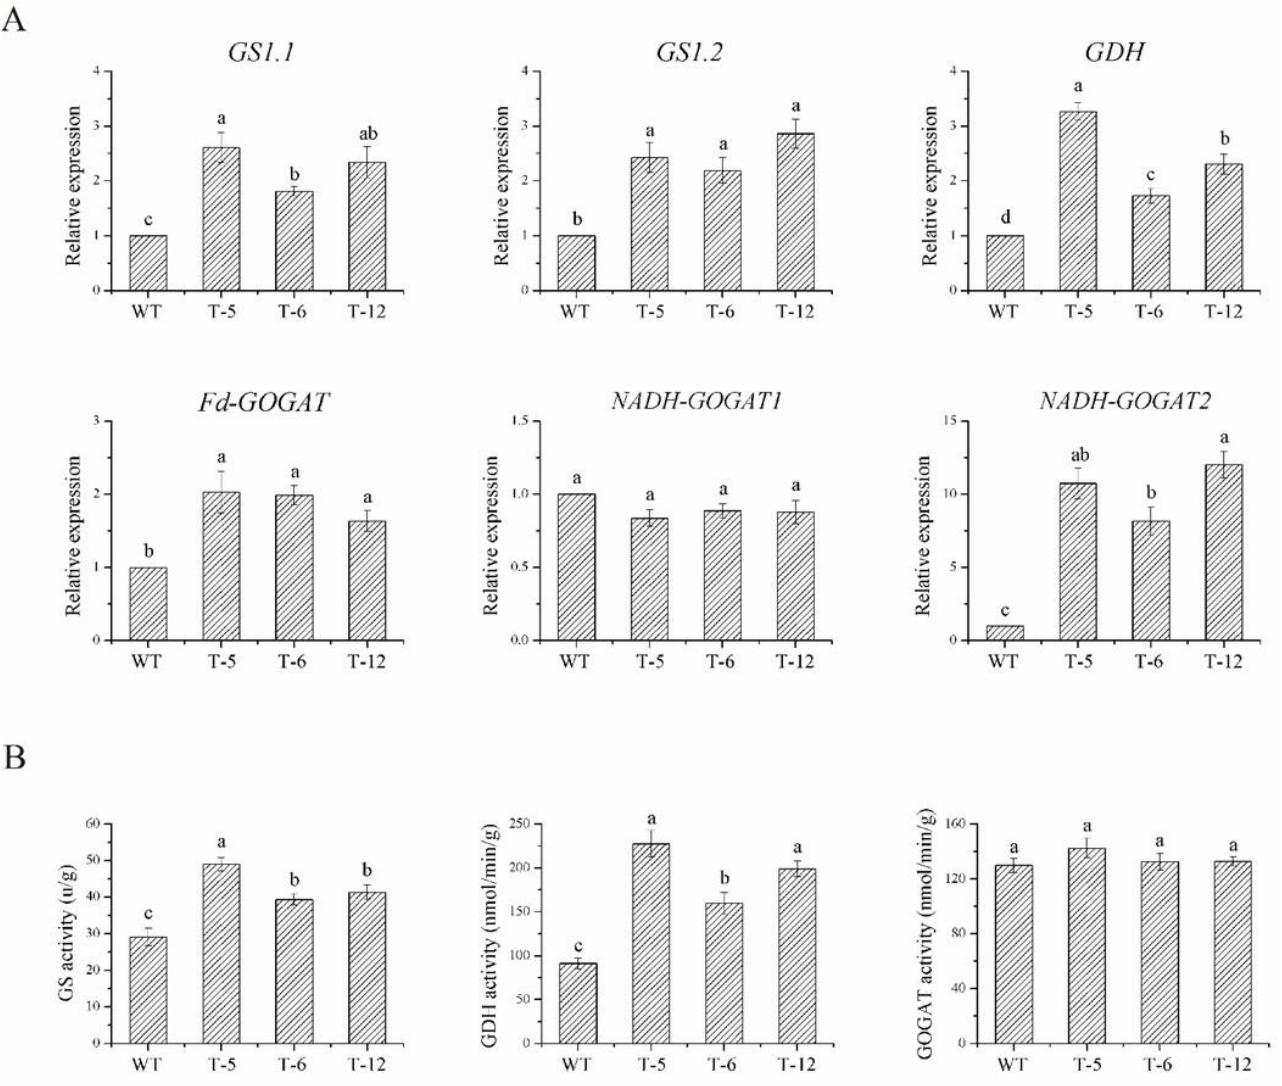
Figure 7. The gene expression levels and enzyme activities of ammonium assimilation-related enzymes in the transgenic rice under low N stress. Notes: ( A ), The expression levels of ammonium assimilation-related enzyme genes in the transgenic rice under low N stress. ( B ), The activities of three ammonium assimilation-related enzymes in the transgenic rice under low N stress. WT: wild-type. T-5, T-6, T-12: different transgenic lines. Data were presented as the mean ± standard error ( n = 3). Bars with different letters were significantly different at the p < 0.05